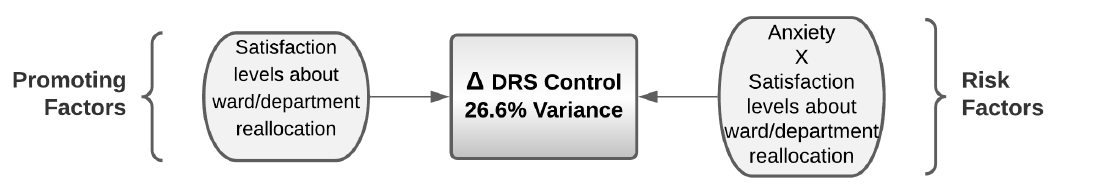
Figure 6. Promoting and risk factors for the variance in the hardiness assessed by DRS control resulting from the logistic